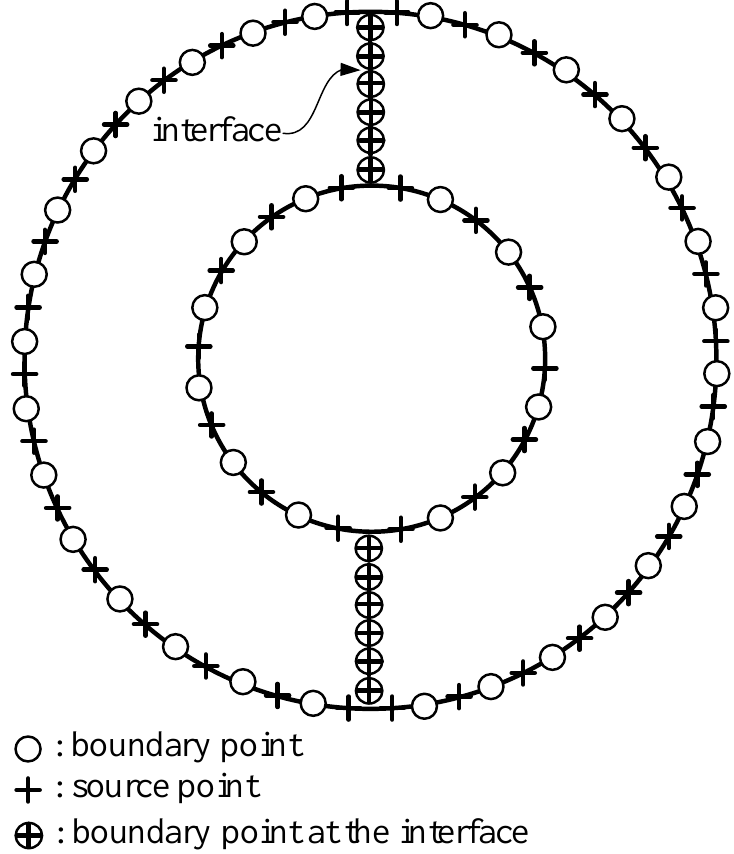
Figure 11. Collocation points for a doubly connected region.